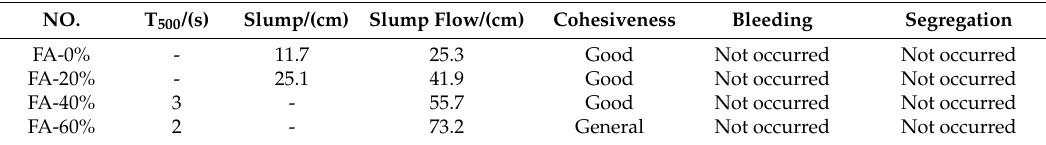
Table 4. Flesh properties of concrete mixture.